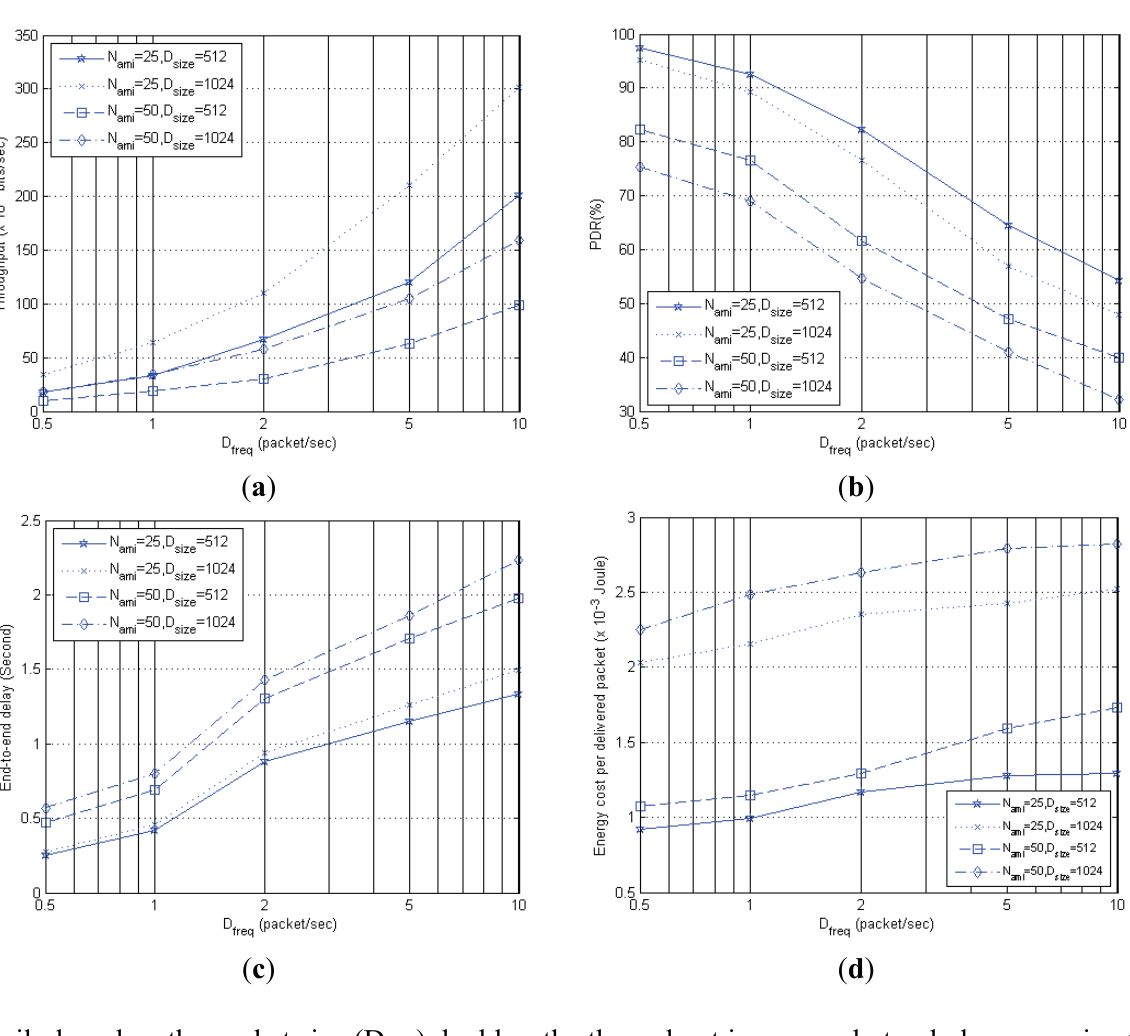
Figure 19. ( a ) Throughput; ( b ) PDR; ( c ) End-to-end delay; and ( d ) Energy cost performances under traffic parameter